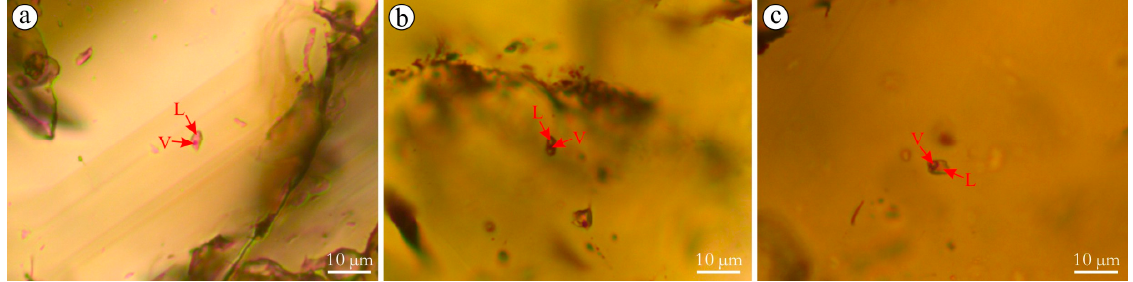
Figure 11. Photomicrographs of the L–V-type fluid inclusions trapped in ( a ) dark red garnet, ( b ) green garnet and ( c ) light brown garnet.